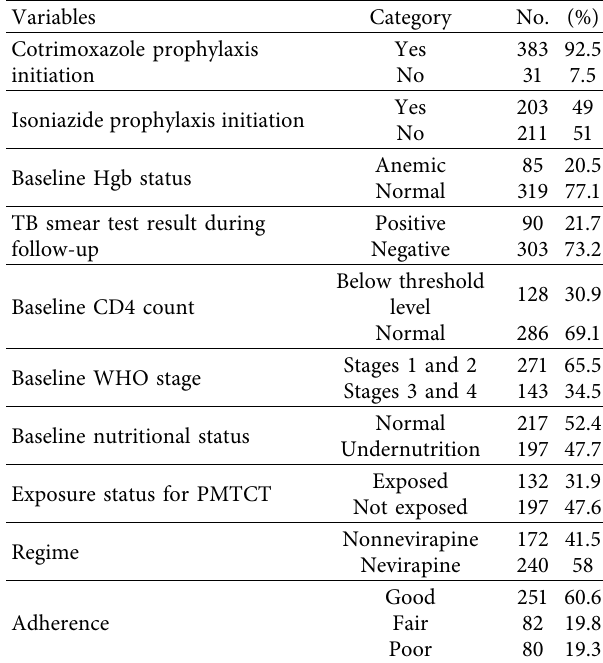
Table 2: Baseline clinical status among children who started ARTat public health facilities between January 1, 2011, and December 30, 2015, in Shashamene town, Oromia Region, Ethiopia,